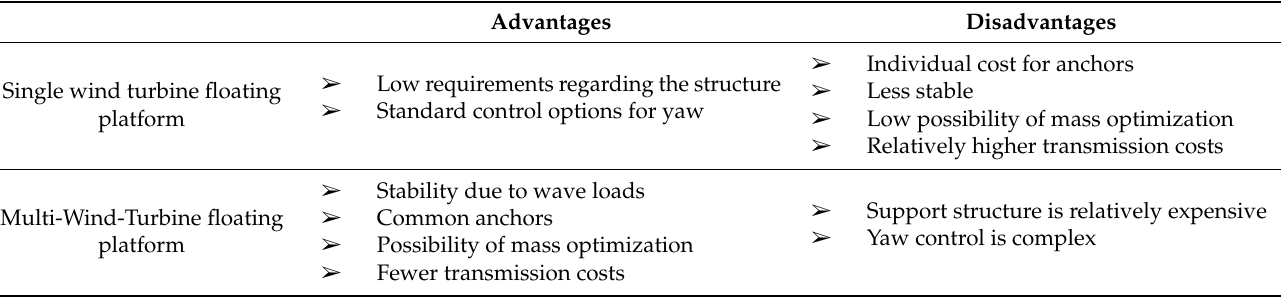
Table 3. Comparison of single and multiple wind turbine floating platforms.